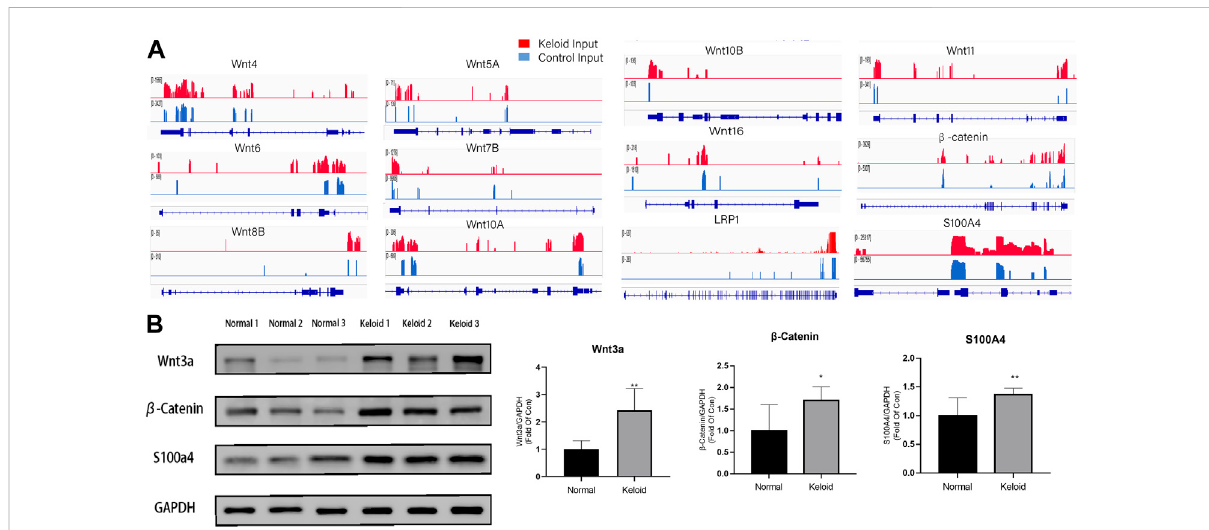
FIGURE 4 Difference between the m 6 A modi fi cation and the activation of the Wnt/ β -catenin pathway between the two groups. (A) m 6 A modi fi cation of LRP1,Wntisoforms,and β -CatenininkeloidcomparedwiththatinNSinthecombinedanalysisofMeRIP-seqandRNA-seq. (B) Proteinexpressionof the Wnt/ β -catenin/S100A4 proteins in keloid compared with that in NS. * p < 0.05, ** p < 0.01.